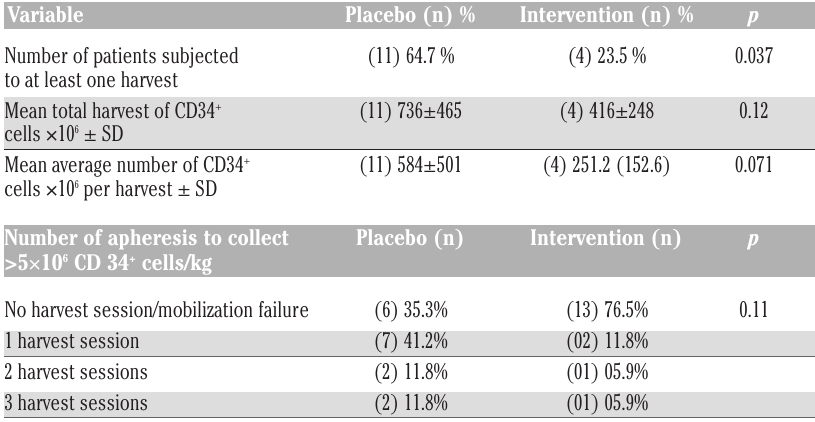
Table 2. Fraction of patients subjected to harvest of an autograft (phase